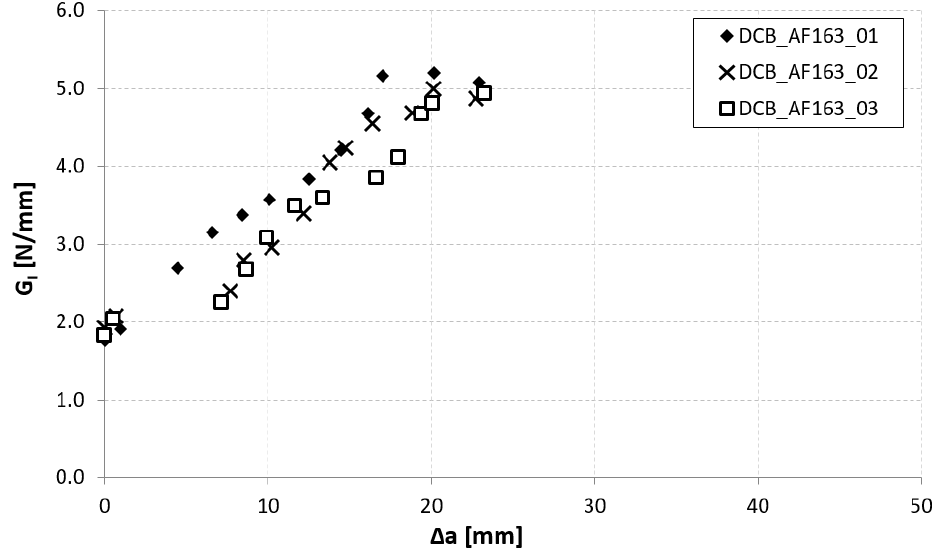
Figure 29. Mode I R-curve of DCB_AF163 joints.